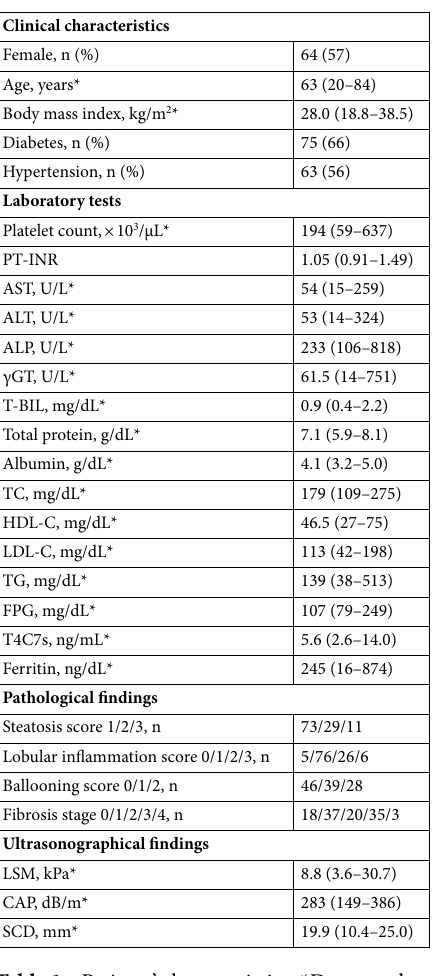
aminotransferase; ALP, alkaline phosphatase; γGT, γ-glutamyl transpeptidase; T-BIL, total bilirubin; TC, total cholesterol; HDL-C, high-density lipoprotein cholesterol; LDL-C, low-density lipoprotein cholesterol; TG, triglycerides; FPG, fasting plasma glucose; T4C7s, type IV collagen 7 s; LSM, liver stiffness measurement; CAP, controlled attenuation parameter; SCD, skin–capsular